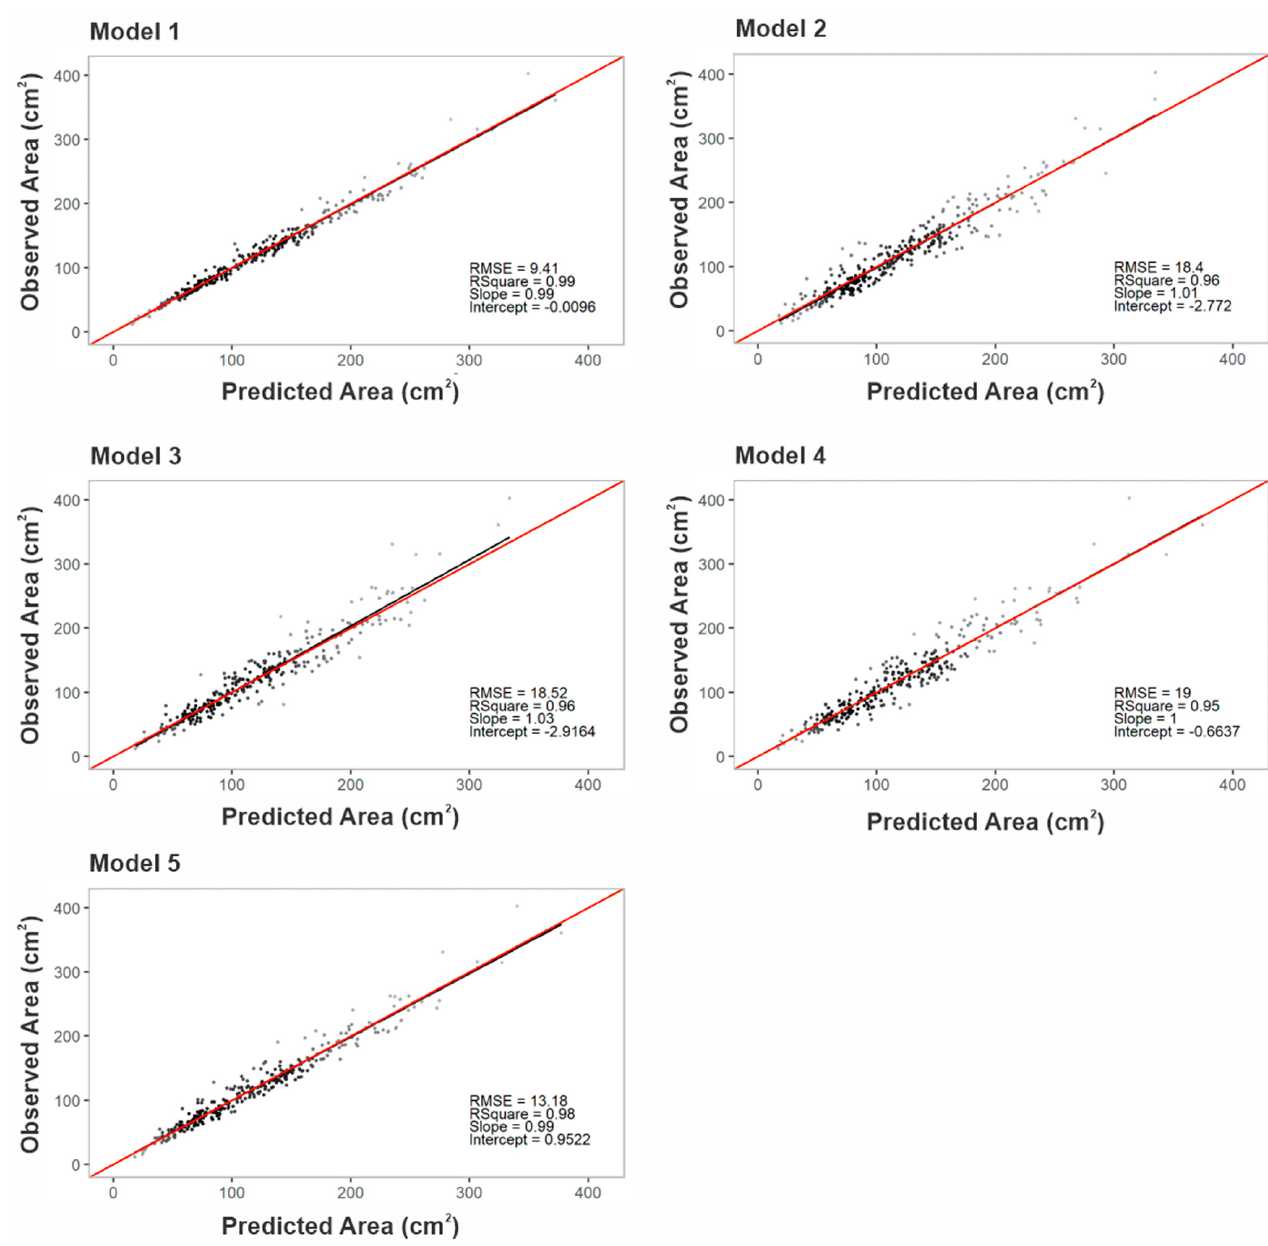
Figure 3. Relationship between the observed leaf area and the predicted leaf total area of improved lines of common bean for the five evaluated models. Regression line of observed versus predicted values: red line, reference line (x = y): black line.